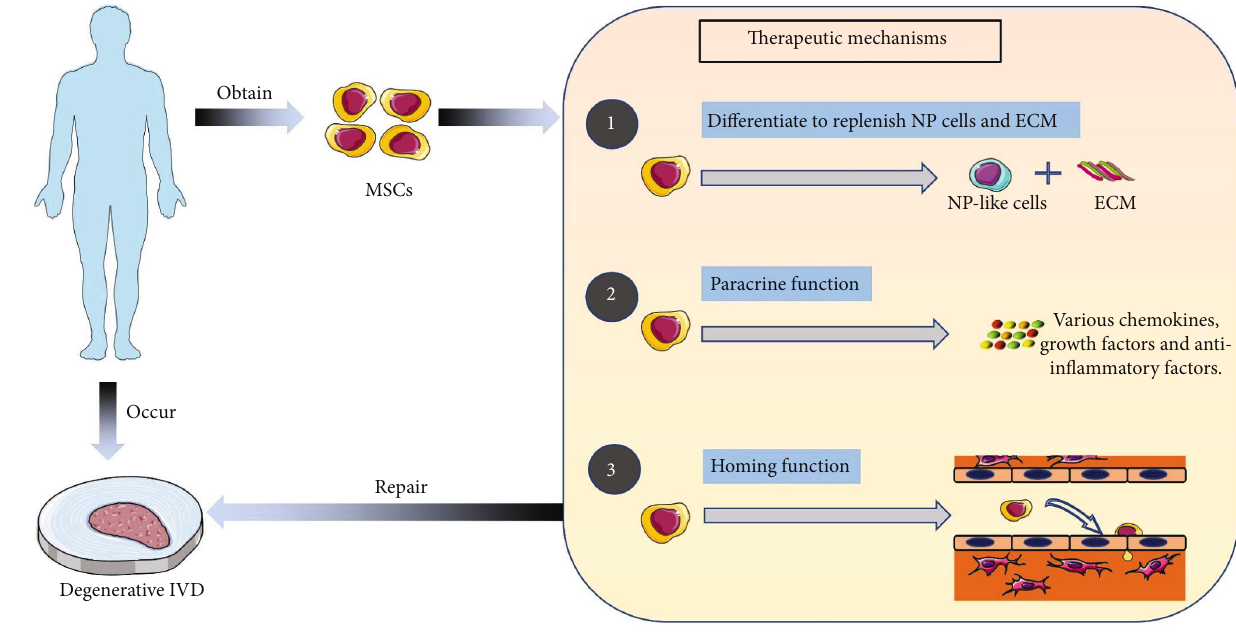
Figure 1: The main mechanisms of MSCs in the treatment of IDD. ECM: extracellular matrix; IVD: intervertebral disc; MSCs: mesenchymal stem cells; IDD: intervertebral disc degeneration. Table 1: Common types of MSCs and their